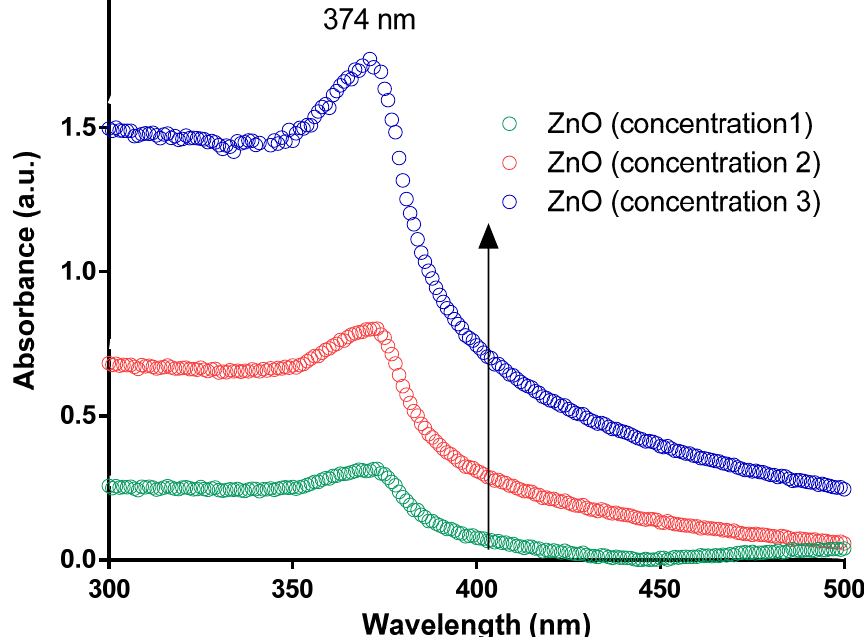
Figure 1. UV-vis spectrum of the generated and rigorously purified ZnO NPs Citrullus colocynthis (L.) Schrad leaves extract suspended in aqueous solution as measured at ambient temperature with a single peak corresponding to the generation of ZnO NPs with maximum absorbance at λ 374 nm. The spectrum suggests a complete reduction of Zn cations using leaf extract, and the generated NPs were formed regardless of the concentration of plant extract added to the reaction mixture.